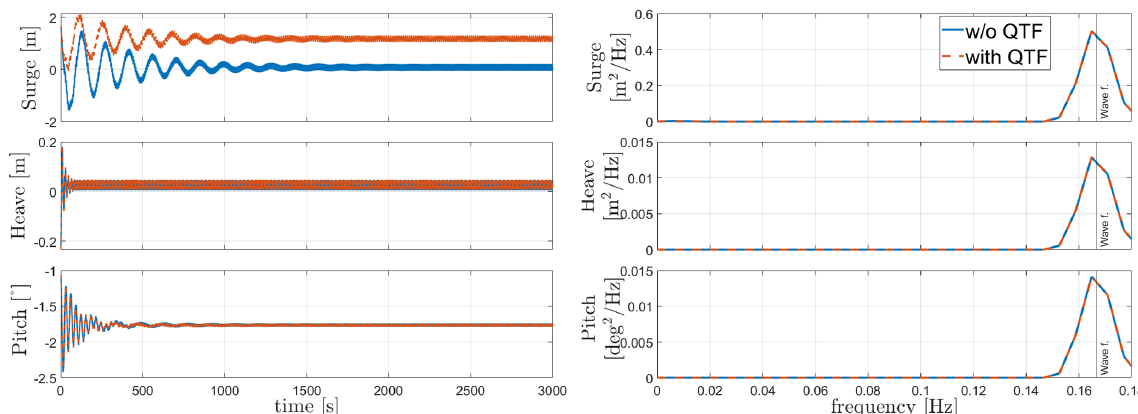
Figure 7. Activefloat’s response to regular waves without and with second-order forces ( T = 6s ,H = 2m).